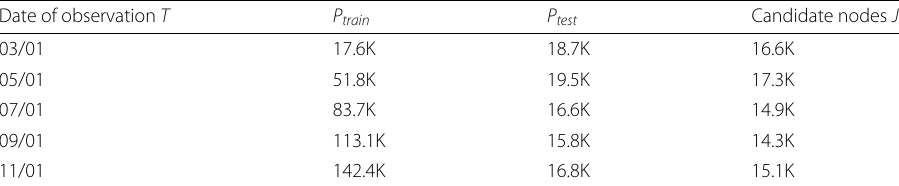
Table 2 Size of training, test and candidate sets at different time points in 2011, which are derived from the TDI